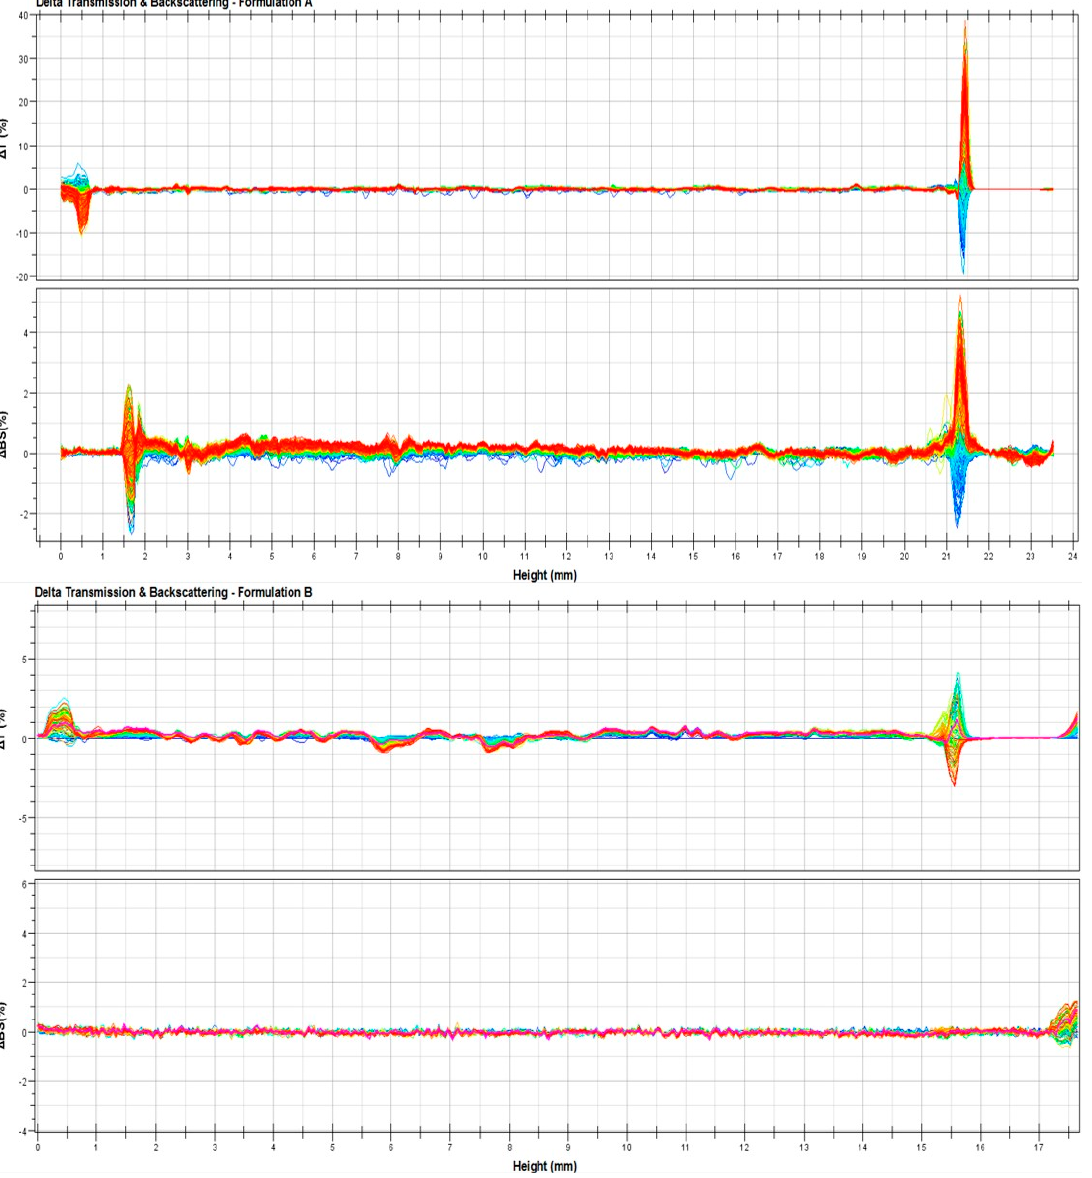
Figure 4. Delta transmission ( Δ T) and delta back scattering ( Δ bs) profiles of (up) formulation A and (down) formulation B. Panels report representative experiments of three independent experiments. Data are reported as a function of sample height.